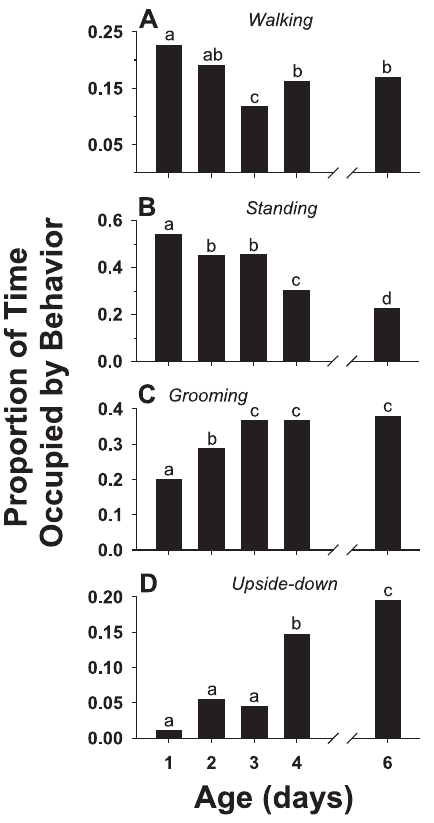
Figure 8. Ontogeny of predominant non-interactive behaviors. Changes in the proportions of total observation time, with respect to age (in days), occupied by each of the four most predominant non- interactive behaviors (see Table 1 for descriptions) in individual, socially naı¨ve male flesh flies: (A) walking , (B) standing , (C) grooming , and (D) upside-down . Flies were paired in a simple observation arena (the same experiment as Fig. 5). Different letters indicate significant differences.